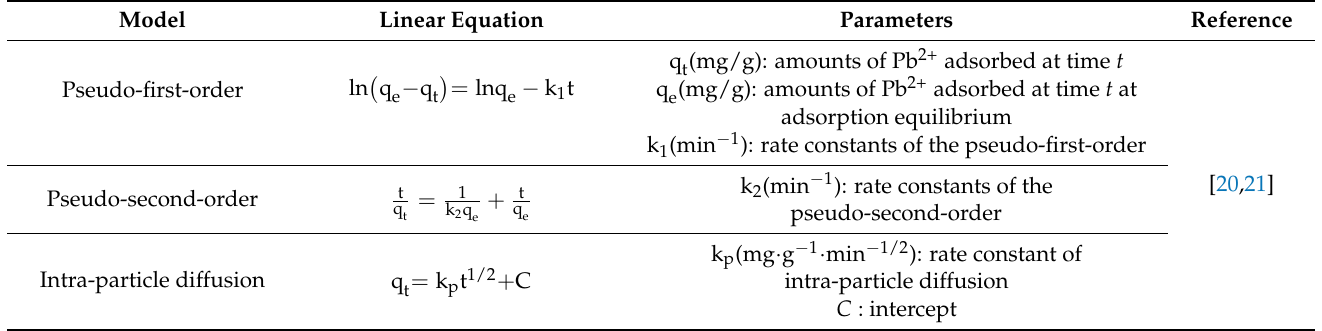
Table 1. Kinetics and adsorption isotherm models used to study the adsorption process.